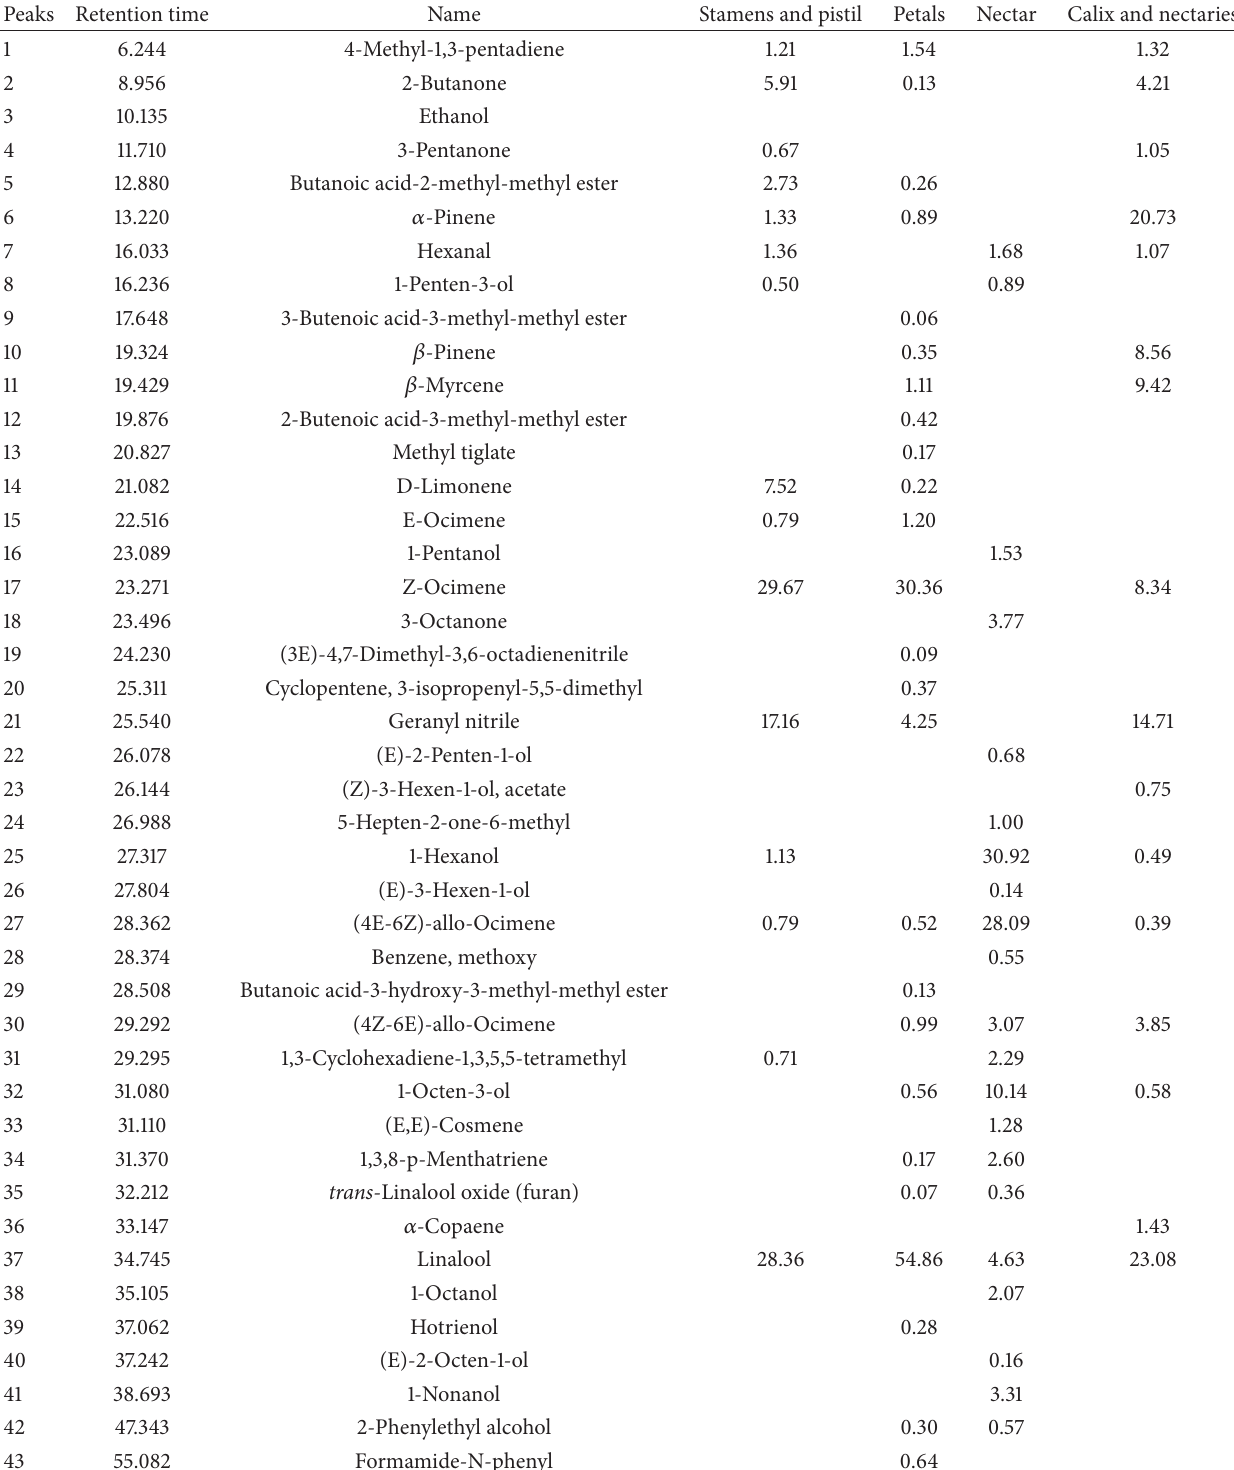
Table 2: SPME-GC/MS analyses of different parts of Robinia pseudoacacia